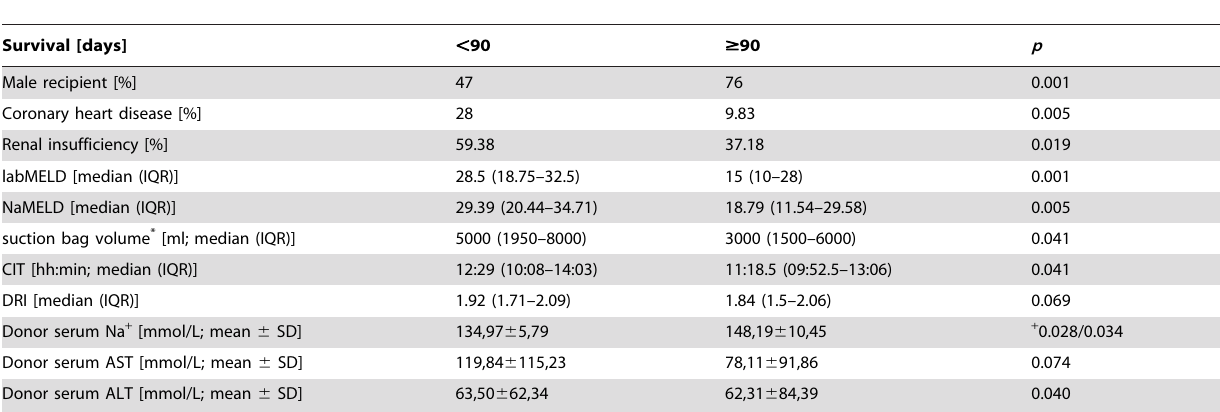
Table 4. The Risk Factors identified in the univariate